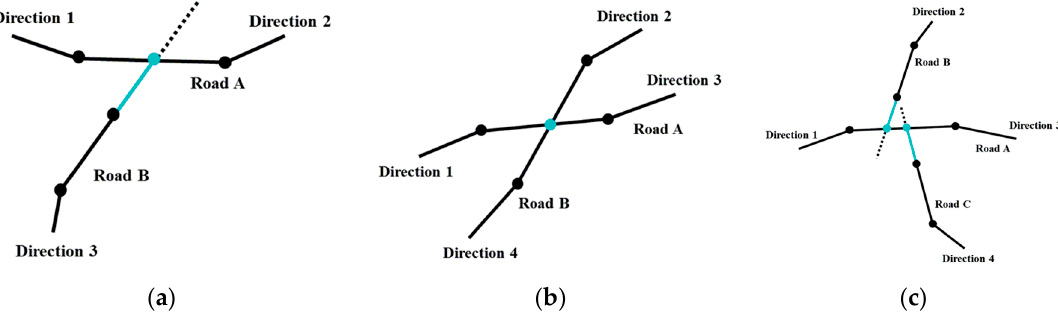
Figure 12. Description of road intersections: ( a ) ‘T’ ‐ or ‘Y’ ‐ shaped intersection; ( b ) simple situation of ‘+’ ‐ shaped intersection; ( c ) multiple situations of ‘+’ ‐ shaped intersections.